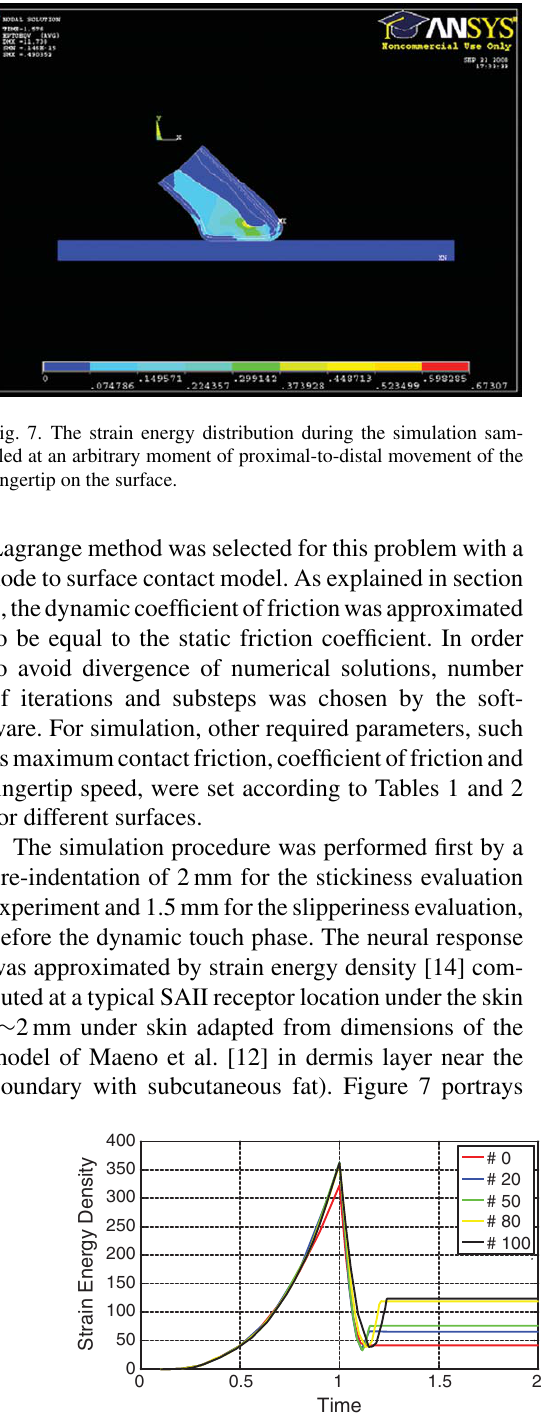
Fig. 8. Prediction of neural response of a typical SAII mechanoreceptor in controlled virtual experiments for evaluation of stickiness (left) and slipperiness